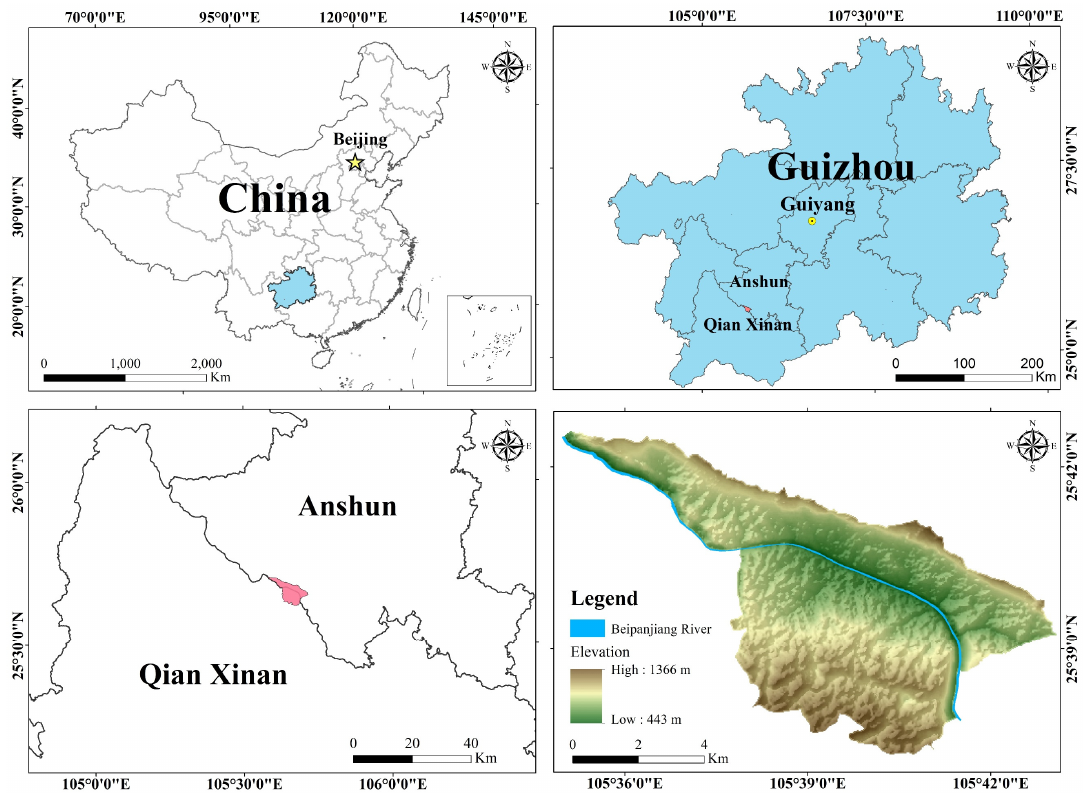
Figure 1. Location and elevation of the study area.